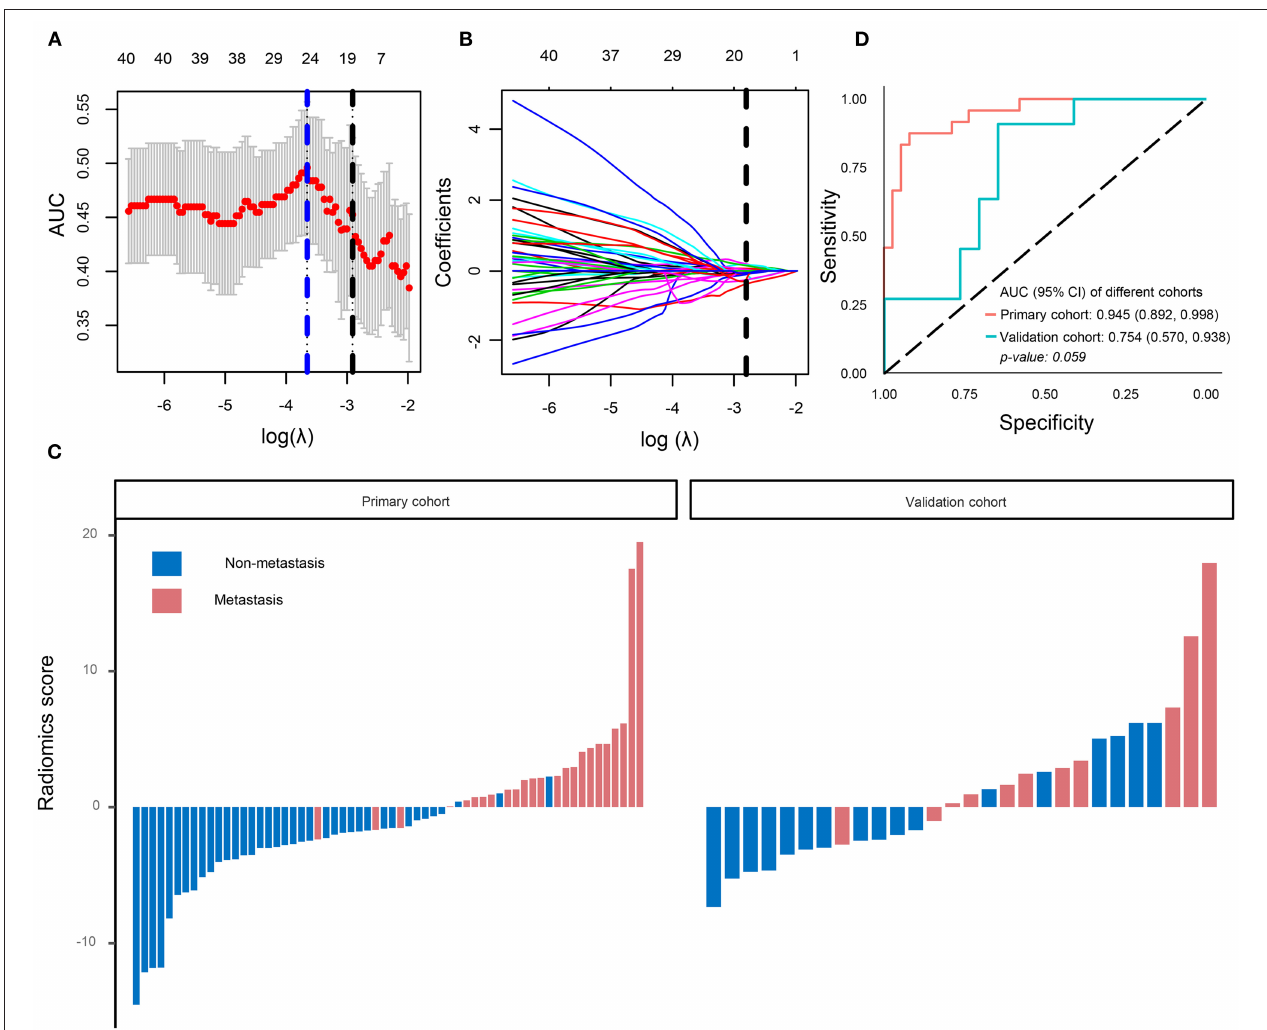
FIGURE 2 | Radiomics signatures selection and model performance. (A) Tuning parameter ( λ ) was selected in the LASSO model by 10-fold cross-validation via minimum criteria. The area under the receiver operating characteristic curve was plotted versus log( λ ). A log ( λ ) = − 2.91 was chosen. (B) LASSO coefficient profiles of the 854 texture features. A coefficient profile plot was produced against the log ( λ ) sequence. Vertical line was plotted at the optimal λ value, which resulted in 16 non-zero coefficients. (C) The radiomics score for each patient in the primary (AUC) cohort ( n = 62) and validation cohort ( n = 28). (D) ROC curve of radiomics model in the primary cohort and validation cohort. LASSO, least absolute shrinkage and selection